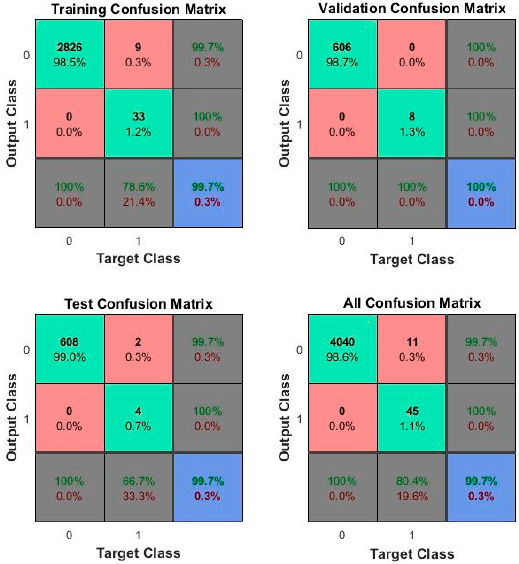
Figure 13. Simple ANN model.